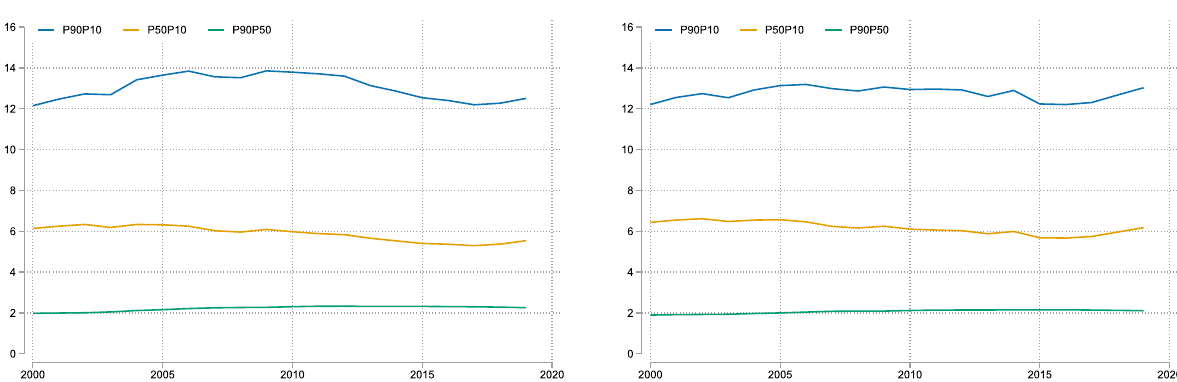
23 The daily, monthly, and annual marginal earnings threshold are provided at http:// doku. iab. de/ fdz/ Bemes sungs grenz en_ de_ en. xls; last accessed: Oct. 23, 2022. 24 In addition to the marginal earnings threshold, we also calculated the respective percentiles for alternative (lower) earnings thresholds (e.g., 100 EUR and 200 EUR). However, the effect of results converging, was most pronounced at the marginal earnings